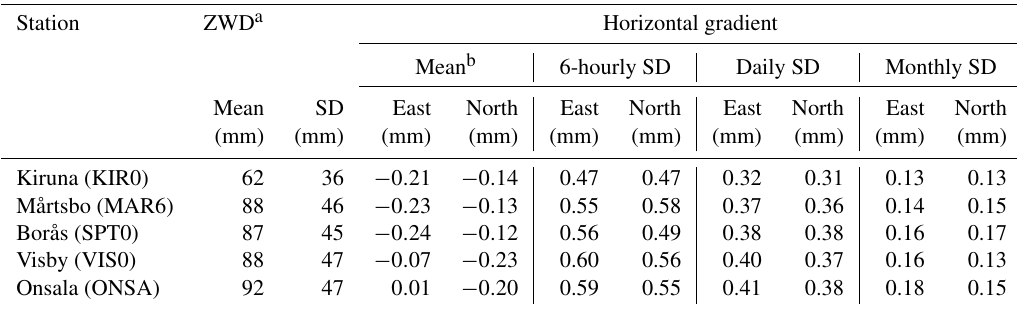
Table 6. Mean values and standard deviations (SDs) over the 11 years of estimated total gradients from GPS data for different temporal resolutions.